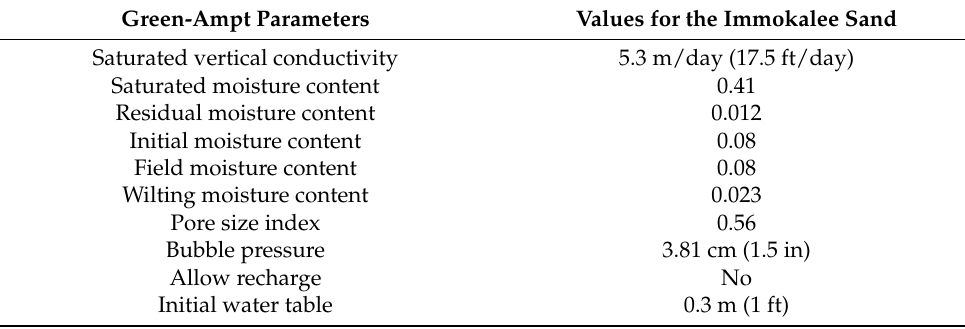
Figure 4. Project limits. Table 2. Green-Ampt parameter inputs for the Immokalee